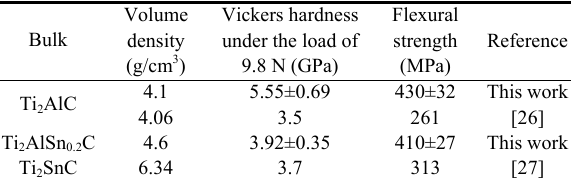
Table 1 Volume density, Vickers hardness, and flexural strength of Ti 2 AlC, Ti 2 AlSn 0.2 C, and Ti 2 SnC